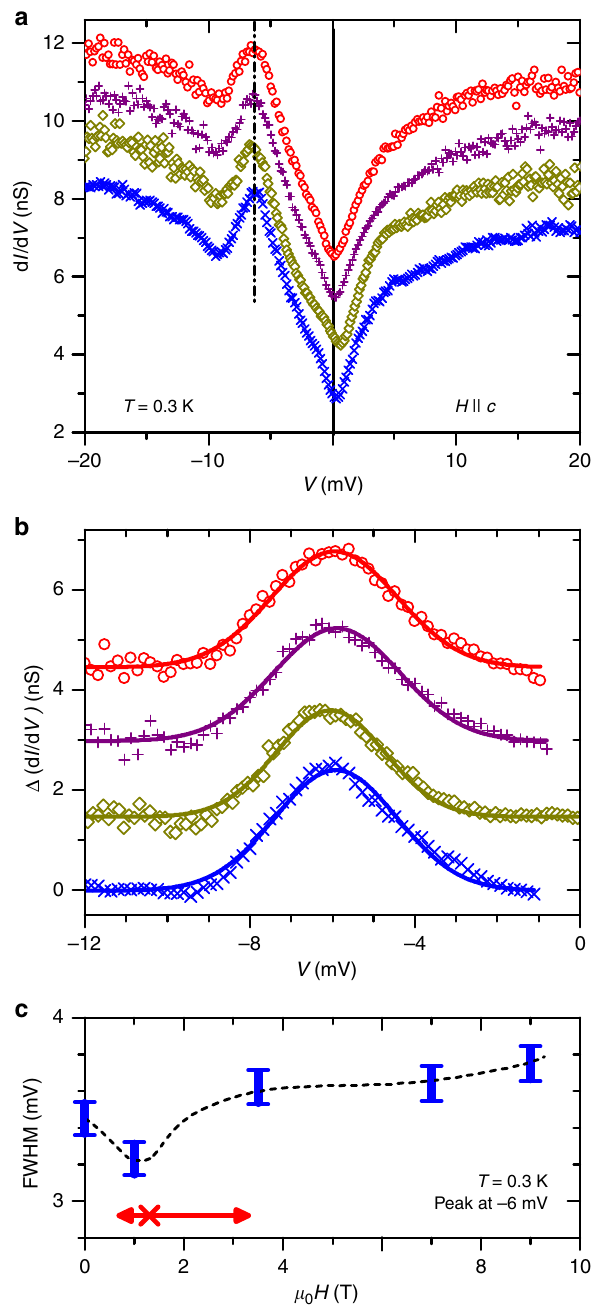
Fig. 5 Spectroscopy in applied fi eld. a Tunneling conductance g ( H , T = 0.3 K) measured at different magnetic fi elds (0, 1, 7, 11 T from bottom to top) applied parallel to the magnetically hard c -axis. Curves are offset for clarity. b Tunneling conductance data of a after parabolic background subtraction (markers) as described in Fig. 3a. Lines are the corresponding Gaussian fi ts; fi elds and color scheme as in a . c FWHM of the Kondo lattice peak for different magnetic fi elds at T = 0.3 K. At this temperature and fi eld orientation, the energy scale T * (cf. Fig. 1) is located at a fi eld of about 1.3 T (red cross 15,17 ), approximately where a minimum is observed in the peak width. Several samples/cleaves were used to establish the existence of this minimum. The red arrow indicates the FWHM of the Hall crossover at T = 0.3 K 16 . Height of blue error bars correspond to the errors of the Gaussian fi ts (Figs. 3a and b) and differences between samples, the line is a guide